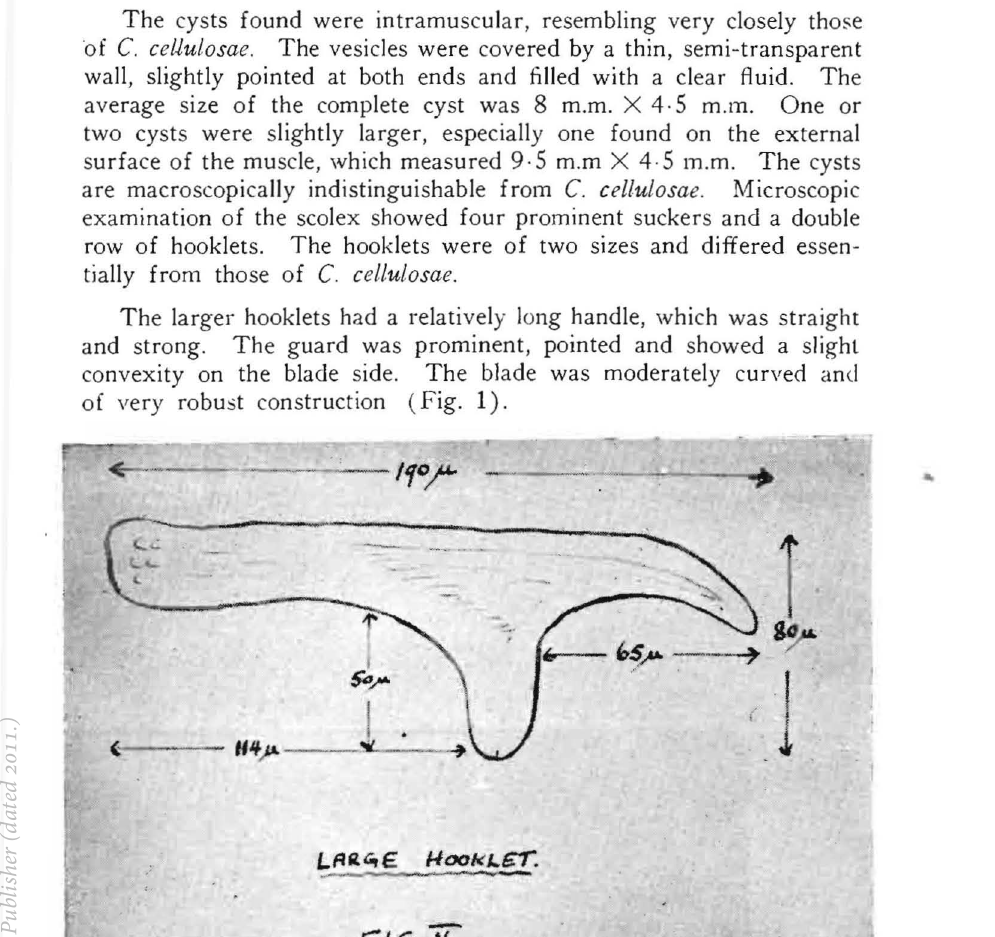
Fig. V. - Diagmm showing measurements of the large